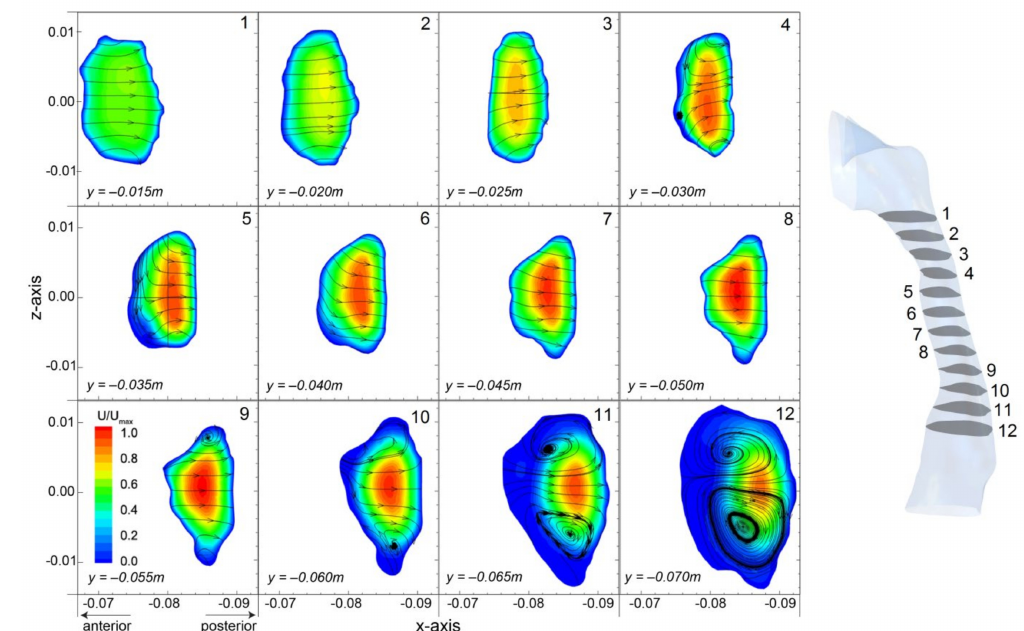
Figure 8. Velocity contours of axial velocity in the y -direction overlaid with cross-flow streamlines ( x - and z - velocity components) in cross-sectional planes at the same y -heights used for the velocity profile comparisons in Figure 6. Each plane is relative to each other in size and location. Velocities are normalised by the global